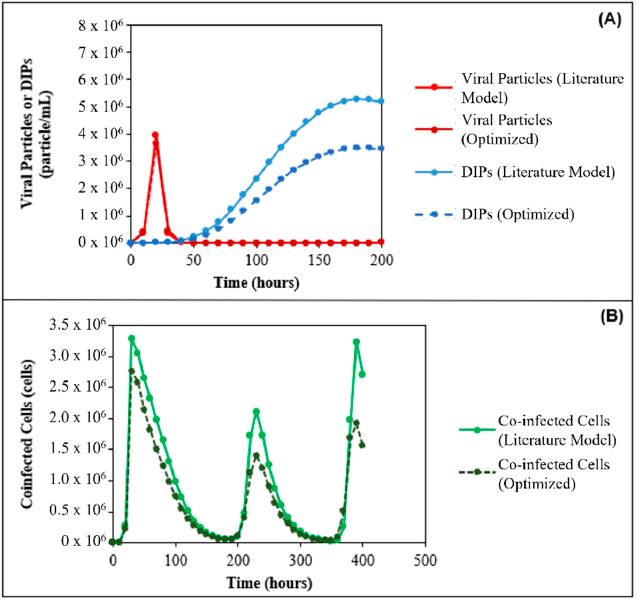
Figure 7. Model optimization: The figures above show the results of the optimization performed on this model. ( A ) The optimization study (which involved reducing the number of cells being fed into the viral reactor by 10%) showed a reduction in concentration of DIP particles formed by one-third. ( B ) This reduction in DIP particles resulted in a corresponding reduction in co-infected cells by approximately 42%.